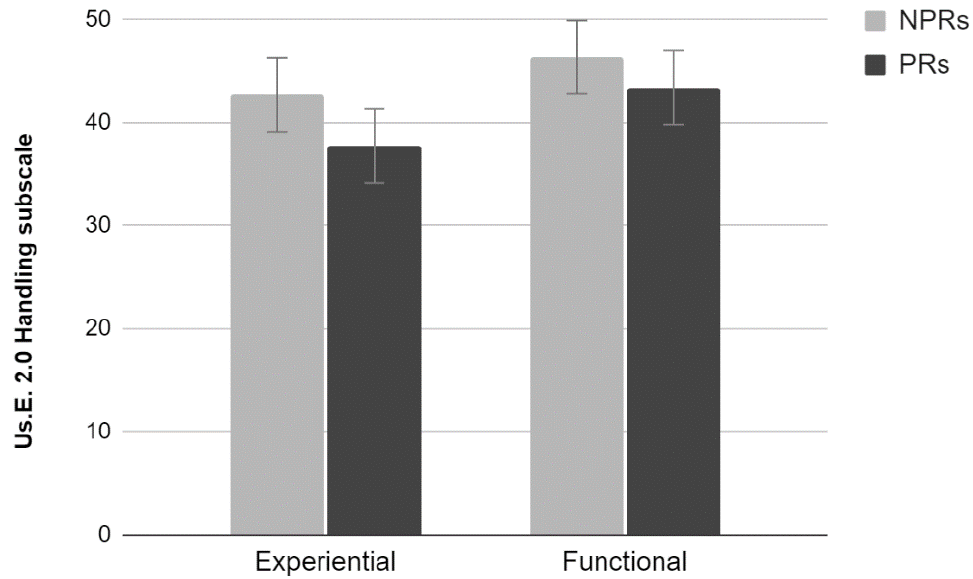
Figure 7. Us.E. 2.0 Handling subscale score by Experience (NPRs vs. PRs) and Test (Experiential vs. Functional). Error bars denote 0.95 confidence intervals.